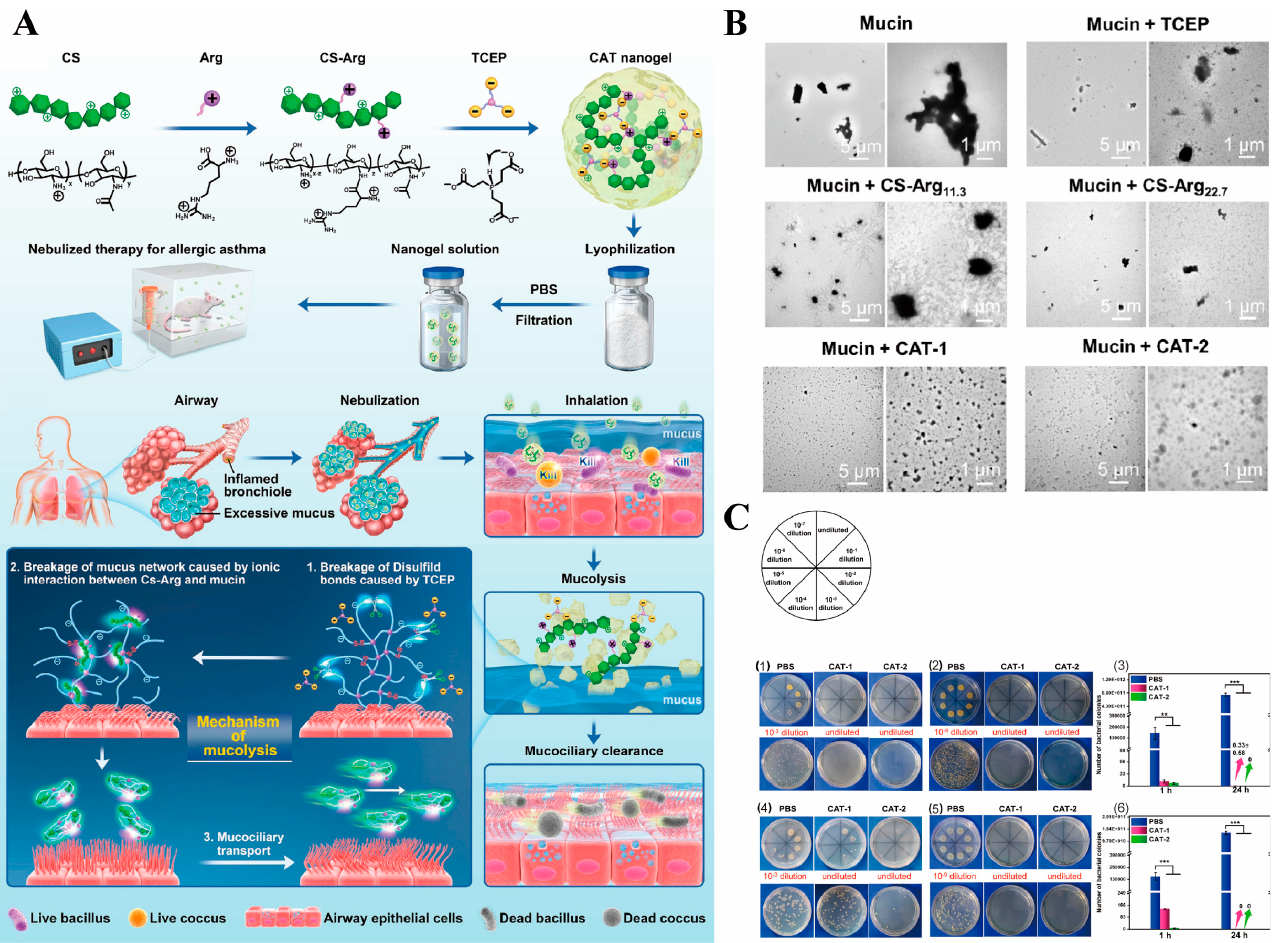
Figure 4. ( A ) The treatment of CS-Arg/TCEP nanogels for asthma. ( B ) TEM images of mucin and mixtures of mucin with different samples. ( C ) Antibacterial experiments of CS-Arg/TCEP nanogels. Reproduced with permission from (1) 1 h and (2) 24 h pictures of the inhibition of different samples against S. aureus aureus. (3) Quantitative of (1-2). (4) 1 h and (5) 24 h pictures of the inhibition of different samples against E. coli aureus. (6) Quantitative of (4-5). Statistics: ** p < 0.01, and *** p < 0.001. [38], Copyright © 2022 American Chemical